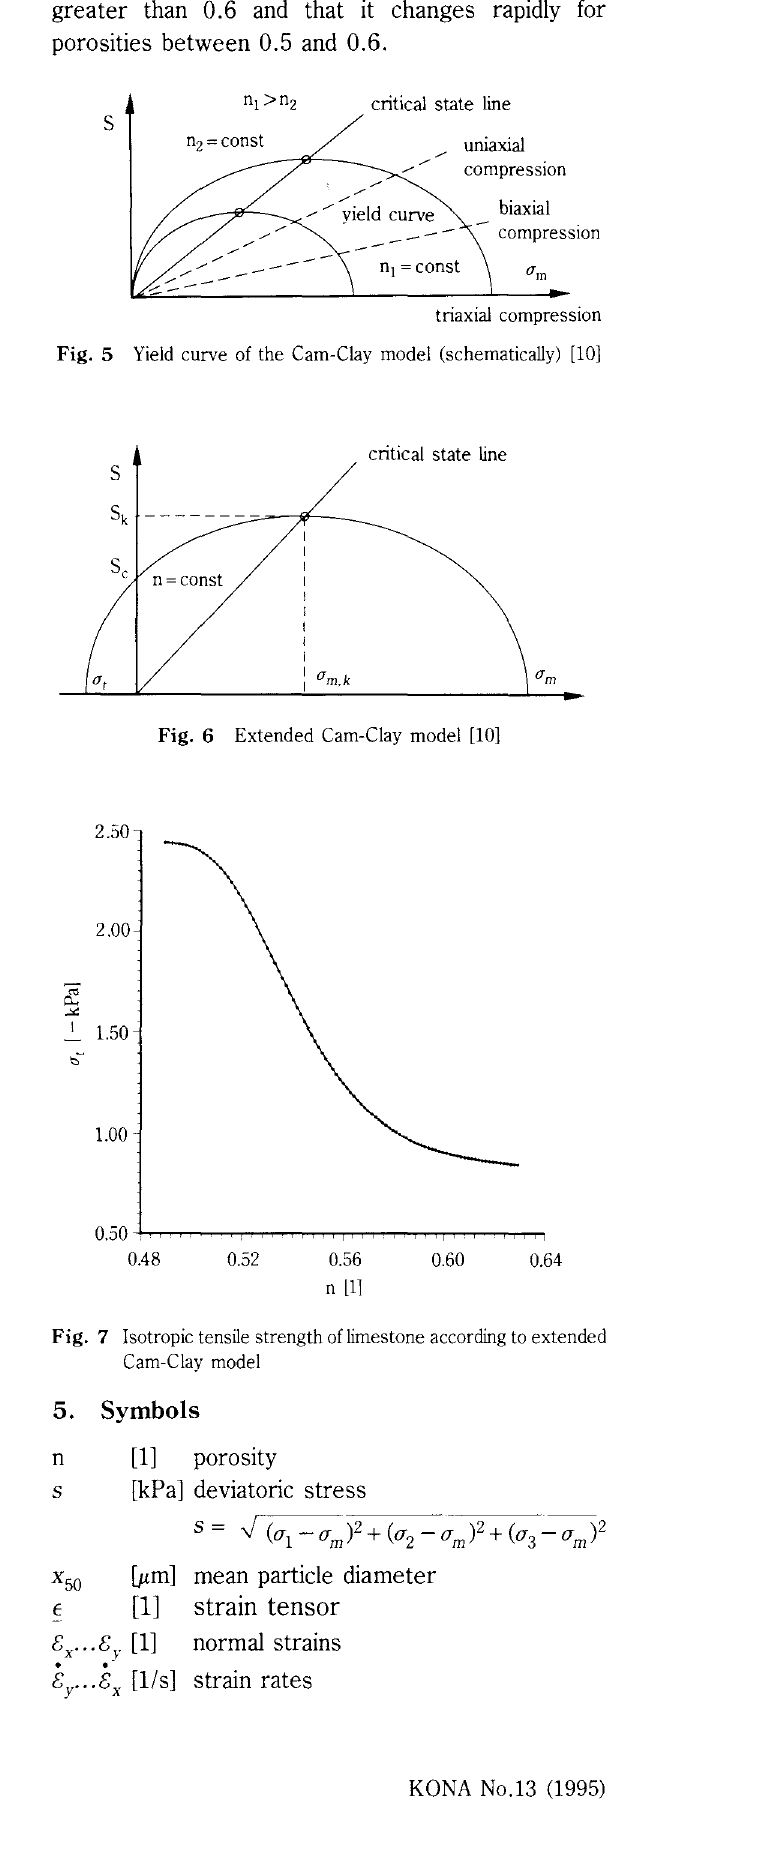
Fig. 5 Yield curve of the Cam-Clay model (schematically) [10]